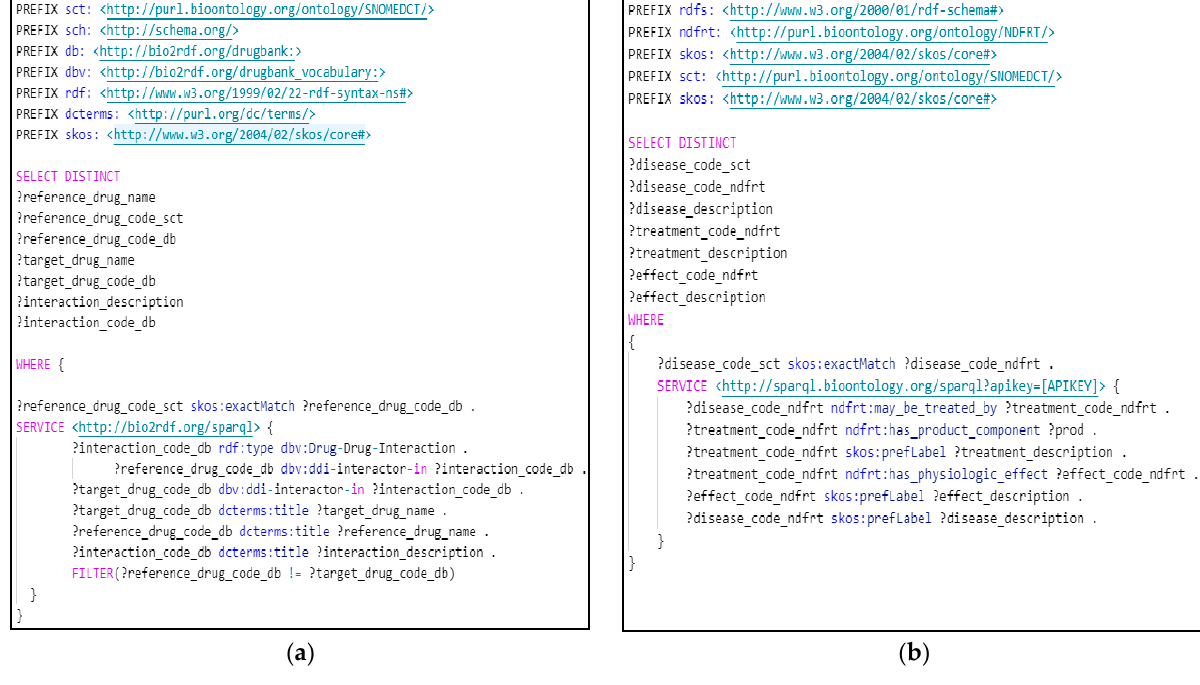
Figure 11. SPARQL queries to obtain the augmentation contents. ( a ) The query to collect the drug–drug interactions. This retrieves interaction descriptions, codes, and names of the drugs involved in each drug–drug interaction. ( b ) The query to retrieve disease-related treatments. This obtains treatments and descriptions related to a given disease. In both cases, queries are parametrized using the EOI binding triples as part of the query graph, and the skos:exactMatch predicate allows filtering the augmentation content by retrieving only the information related to the coded values of the EOI binding triples.